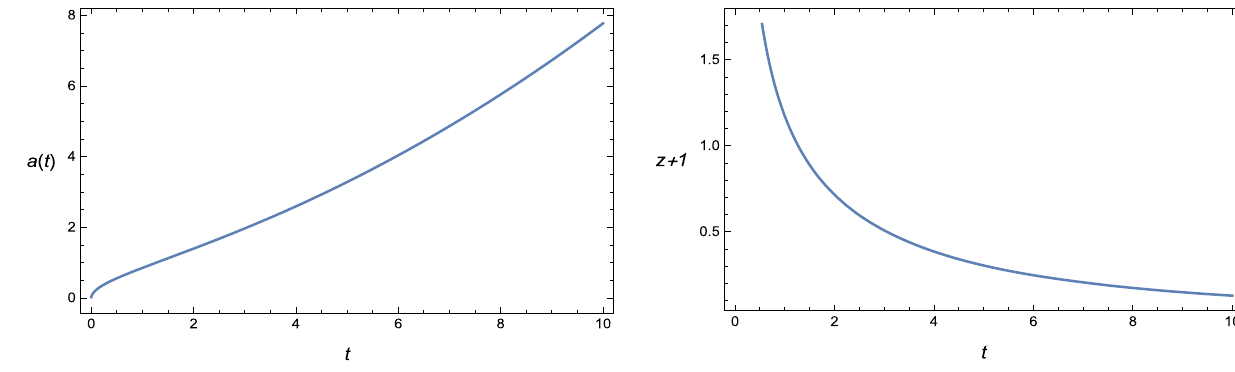
Fig. 1 Evolution of scale factor versus cosmic time and behaviour of redshift function for the case f ( R ,ϕ,χ) = f 0 R 3 2